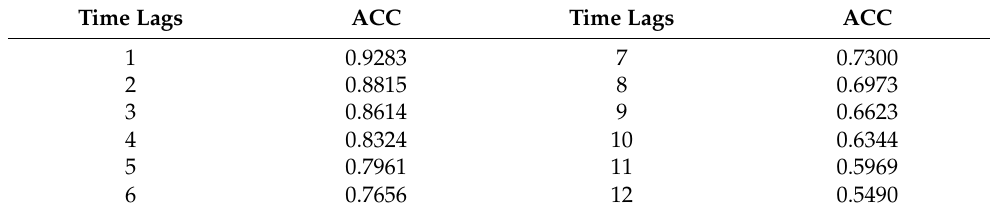
Table 2. Results of the